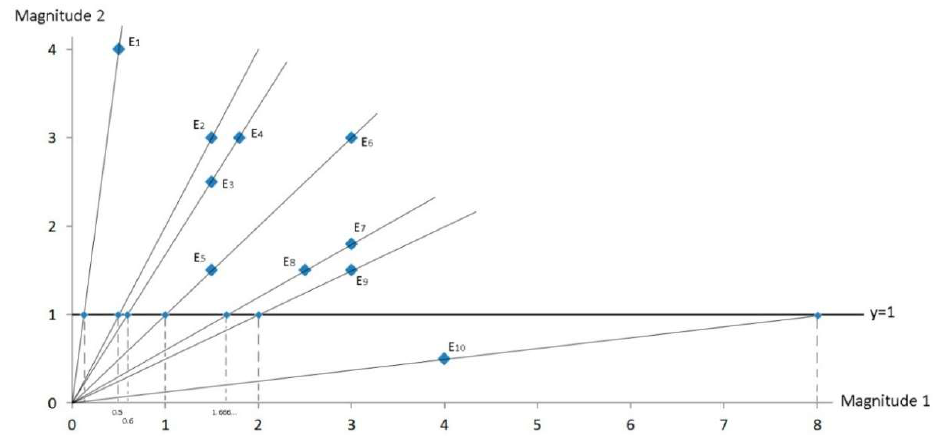
Figure 5. Graphical calculation of the ratios of the ten firms (E 1 to E 10 ) using the projection on the line y = 1. Given that two points ( a , b ) and ( A , B ) that share a line from the origin of coordinates always fulfill the expression (cid:3029) , if b = 1, then a = (cid:3002) .